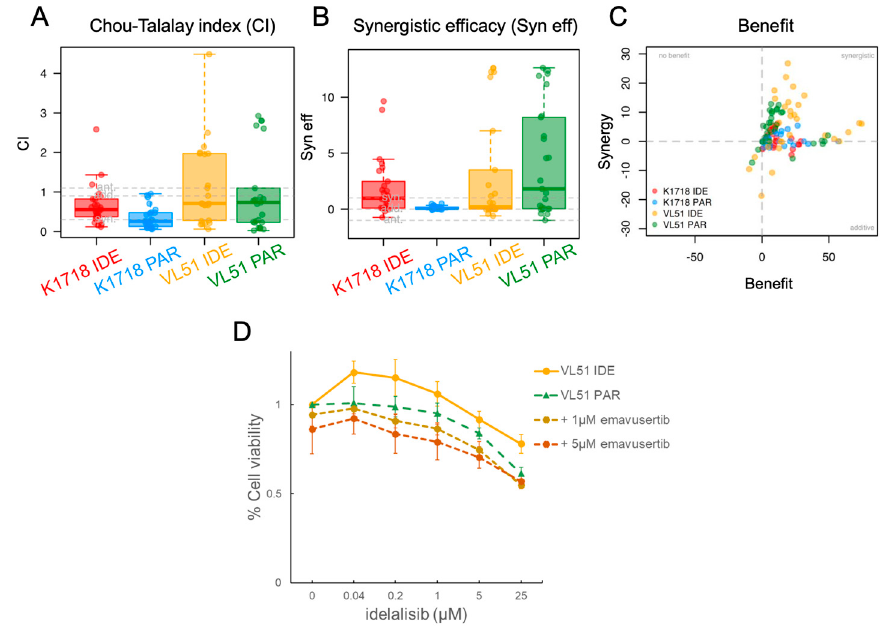
Figure 3. IRAK4 inhibitor emavusertib in VL51 and Karpas1718 (K1718) parental (PAR) and